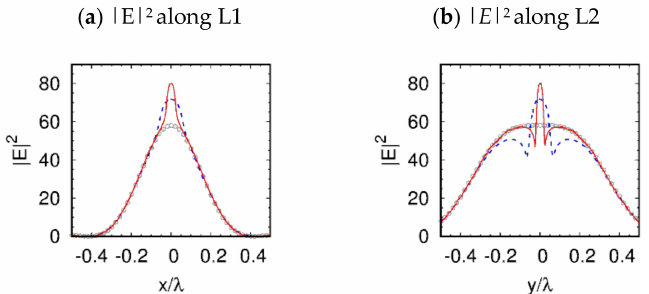
Figure 5. Light intensity along the two imaginary cutting lines L1 and L2, which lie on the shadow surface of the simulated microspheres. L1 is defined as y = 0 and z = D s /2 + 0.001 λ , which is parallel to the x-axis and perpendicular to the polarization direction. L2 is defined as x = 0 and z = D s /2 + 0.001 λ , which is parallel to the y-axis, as well as the polarization direction. The gray circles, the blue dashed lines, and the red solid lines indicate the light intensity of the 3.5 λ -diameter microsphere without hole, the microsphere with a through hole of λ /15 (see Figure 3e–h), and the microsphere with a blind hole of λ /40 (see Figure 4g–i),